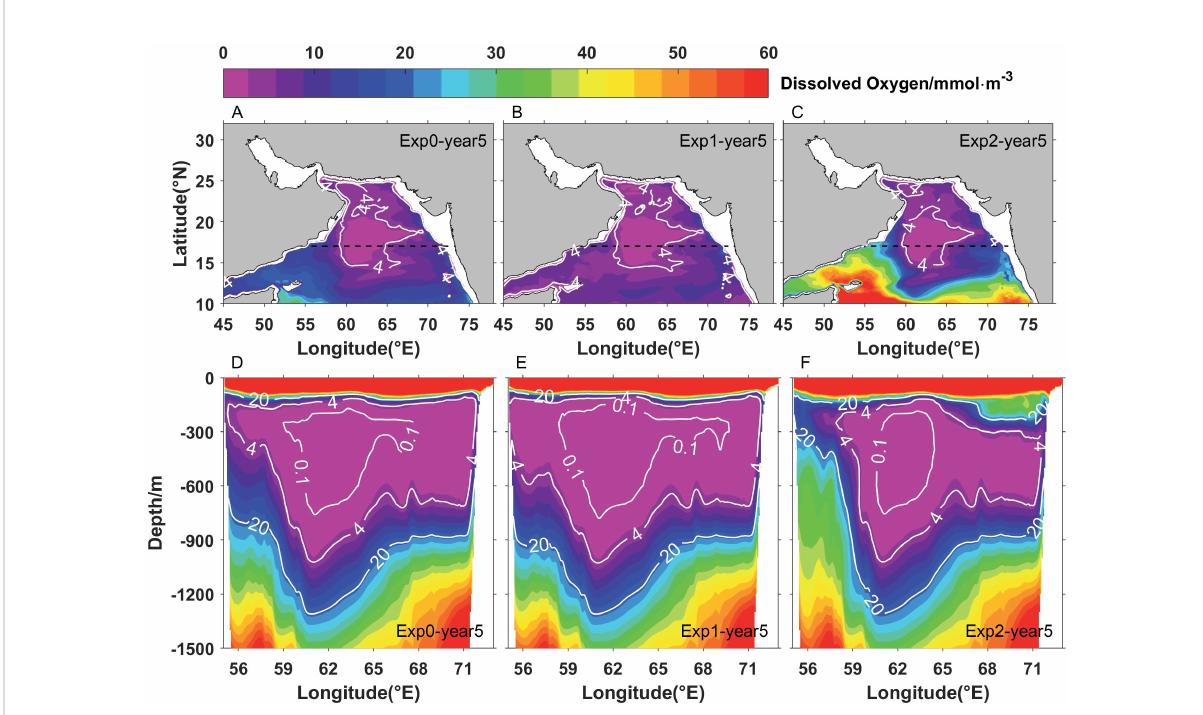
FIGURE 7 Annual mean horizontal distributions of dissolved oxygen (A – C) averaged between 200 and 1,000 m and vertical distributions of dissolved oxygen (D – F) in the upper 1,500 m at 17°N from three experiments (Exp0, Exp1, and Exp2) after 5 years of